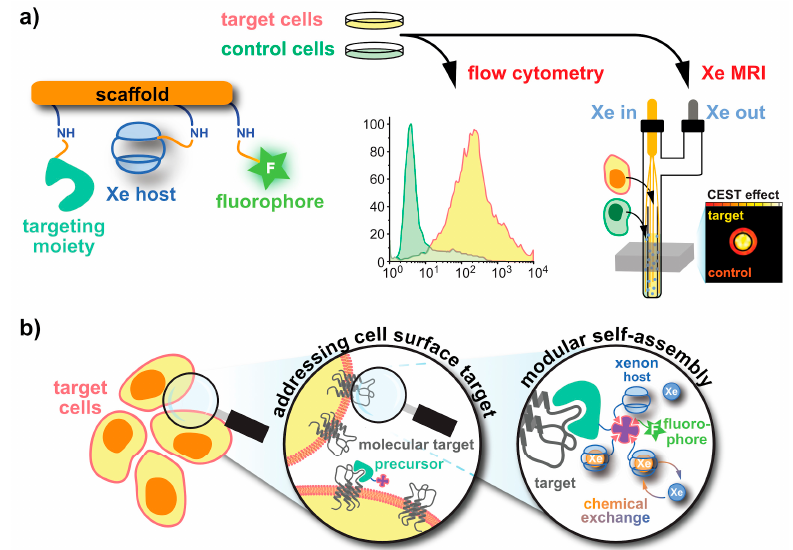
Figure 5. Strategies for obtaining functionalized Xe sensors. ( a ) A Xe host and targeting unit can be coupled to a (peptidic) scaffold via peptide synthesis at activatable tethers (orange). An optional dye label enables combined fluorescence and MRI specificity tests. ( b ) In a modular approach, a functionalized precursor (e.g., an avidin-activated binding motif) can be delivered to the target. Subsequent delivery of biotinylized Xe hosts and dyes yields the complete sensor (see Section 5.2.1).